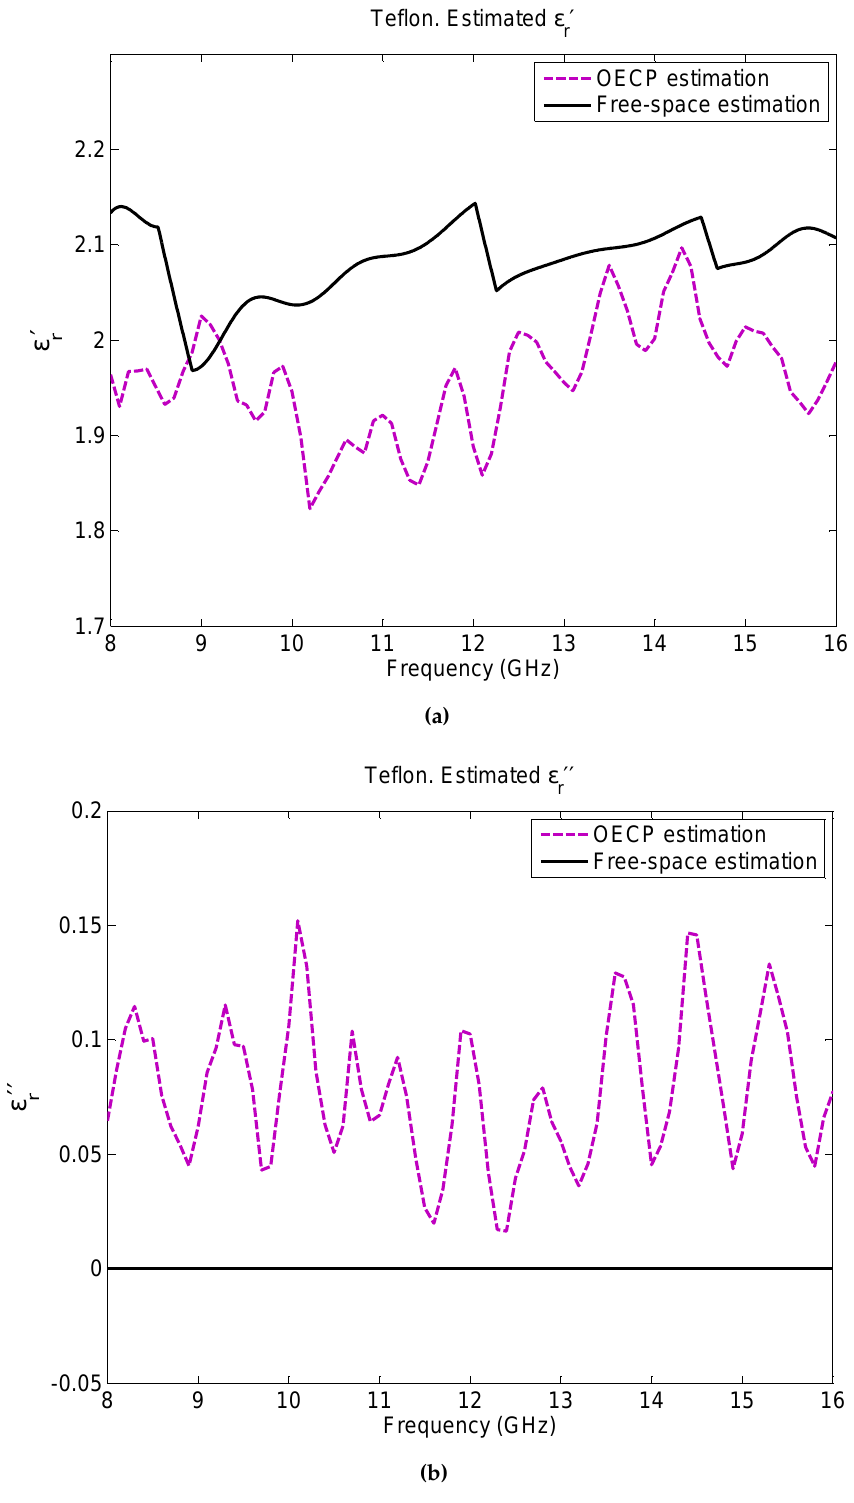
Figure 5. Teflon estimated permittivity: ( a ) (cid:101) (cid:48) r , ( b ) (cid:101) (cid:48)(cid:48) r